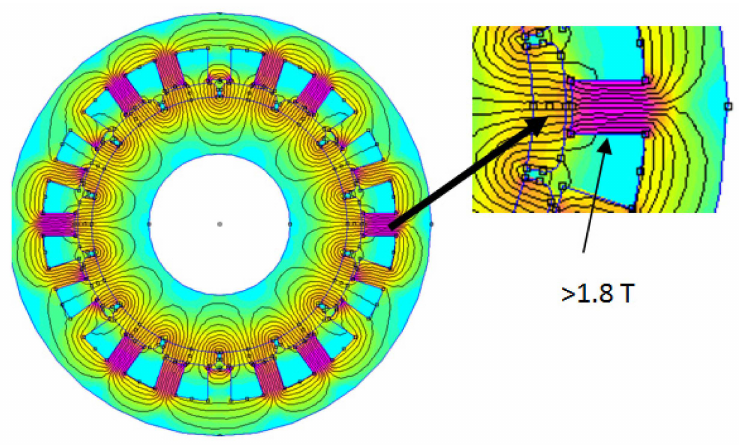
Figure 3. Magnetic flux distribution in a concentrated winding structure having 14 poles and 20 slots (Five phases). At no-load case, the highest level of induction is in the teeth and is higher than the level of induction found in the 12 slots structure (Figure 2). q , the number of slots per pole and phase is 0.28 and is not equal to 1/5 (1/Nph). The number of poles has to